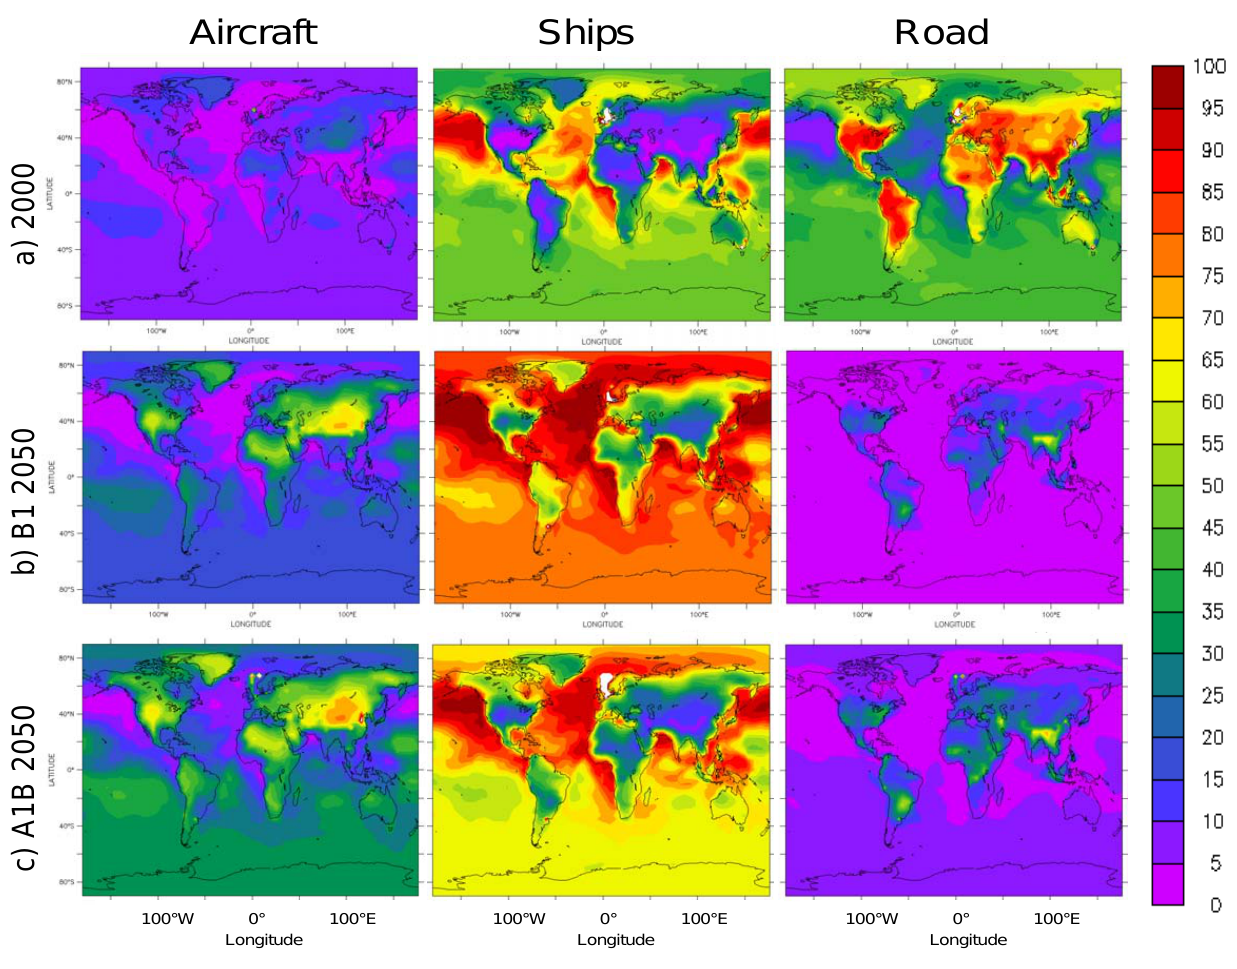
Fig. 3. Same as Fig. 2 for surface ozone mixing